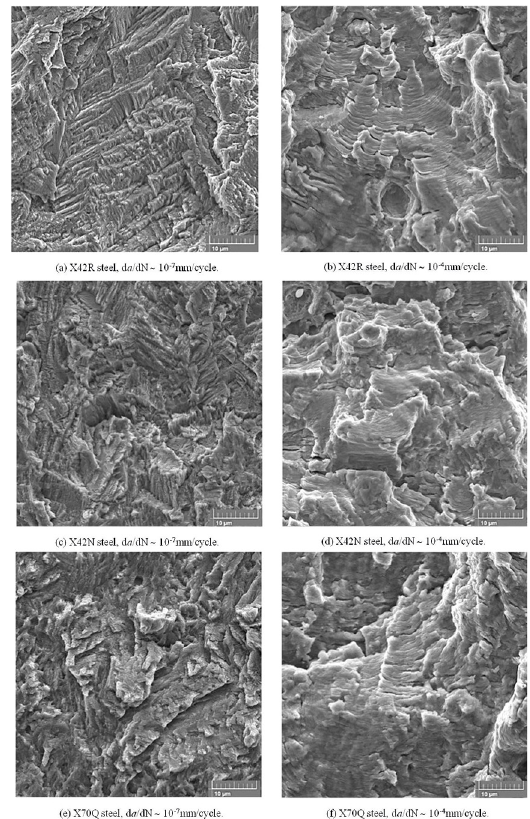
Figure 7. SEM fractographies, fatigue specimens at two crack growth